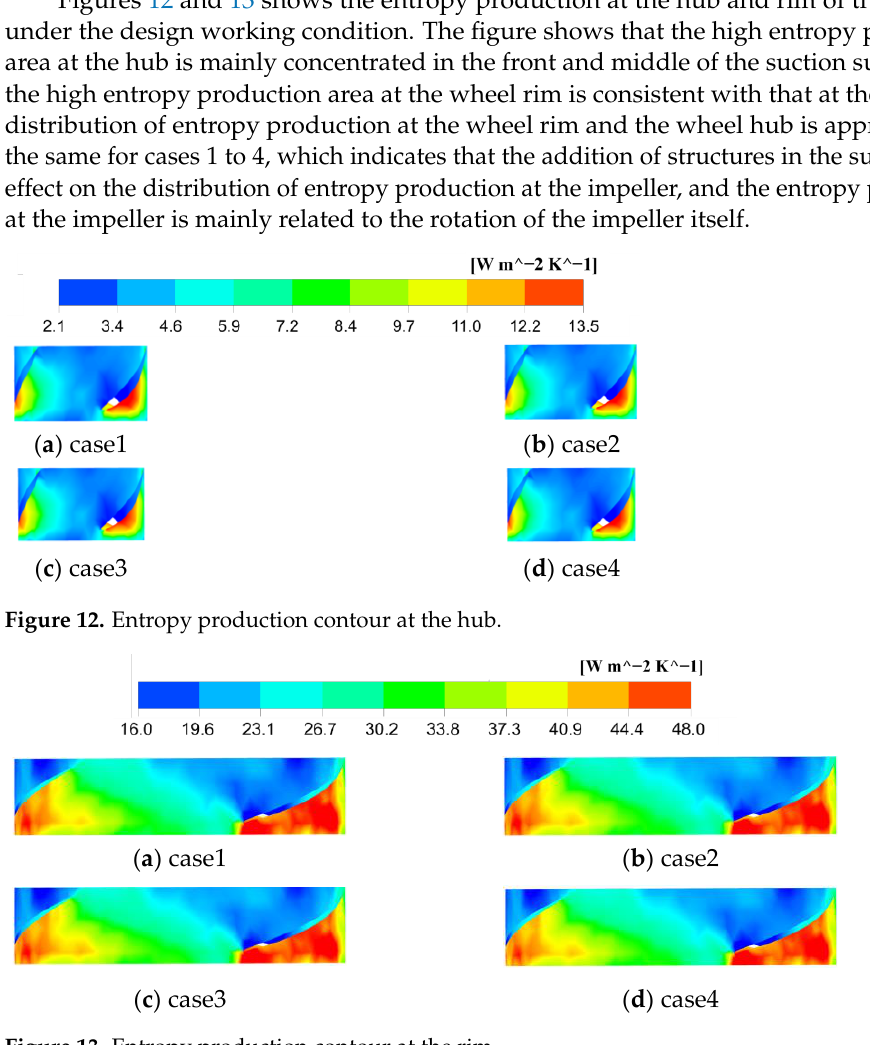
Figure 11. Contour of entropy production distribution in longitudinal section.